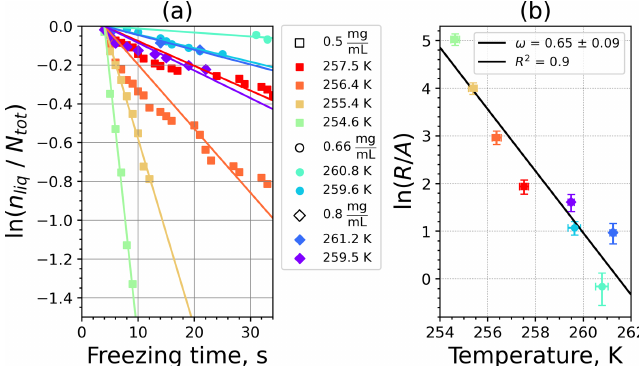
Figure A5. (a) The decrease in fraction of droplets which remained liquid with time at different temperatures in the isothermal experi- ments for feldspar at the M-WT. The colors correspond to different temperatures; experiments with particle concentrations of 0.5, 0.66, and 0.8gL − 1 are plotted by rectangles, circles, and triangles, respectively. Typical error bars are depicted in Fig. 6. (b) Freezing rate of feldspar normalized to surface area as a function of temperature.